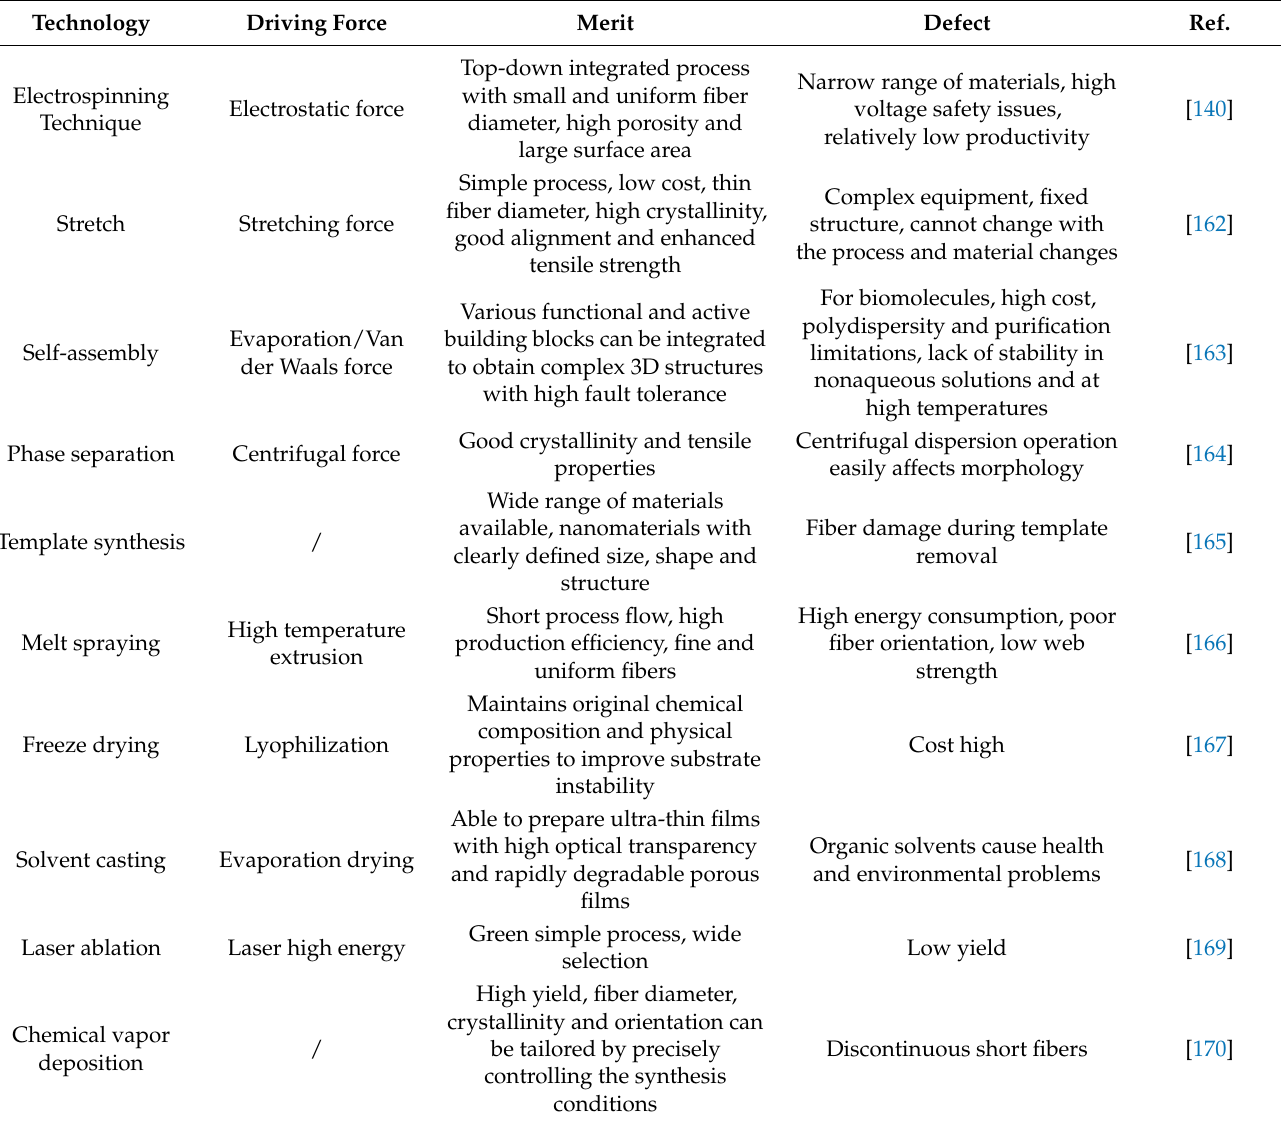
Table 2. Comparison of advantages and disadvantages between electrospinning and other